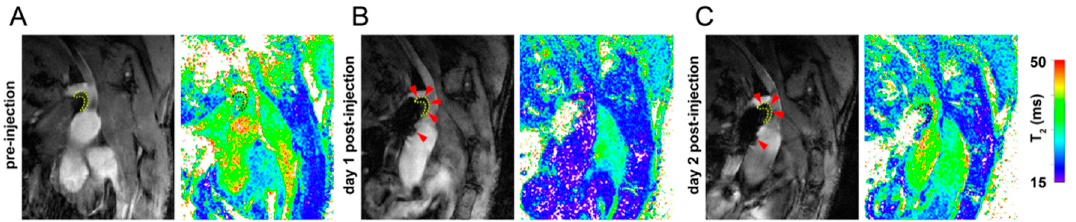
Figure 3. T 1 -weighted anatomical reference images and T 2 -value maps from the same animal ( A ) before and at ( B ) day 1 and ( C ) day 2 after injection of Sinerem. Arrowheads point to locations of contrast agent uptake in the plaques.